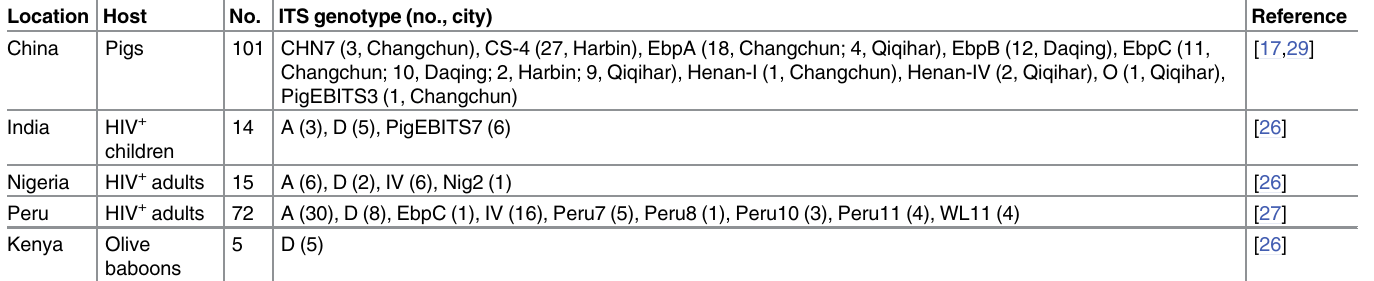
Table 1. Enterocytozoon bieneusi isolates analyzed in this study and their genotypes based on the ribosomal internal transcribed spacer (ITS) sequences. Location Host No. ITS genotype (no.,